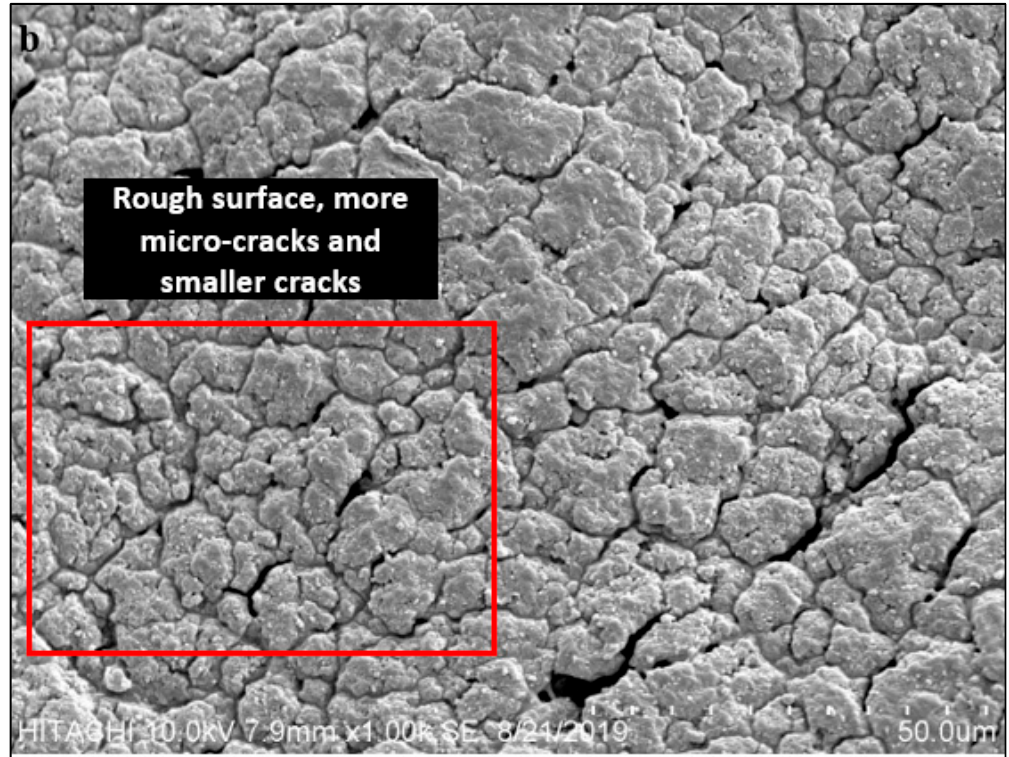
Figure 8. SEM of 10% NaOH treated rubber surface morphology.